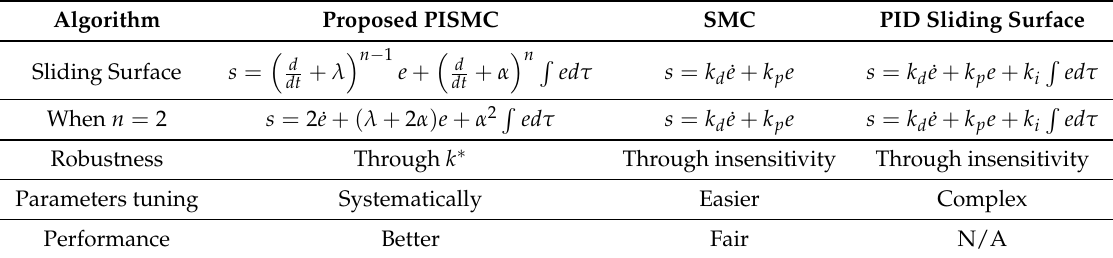
Table 2. Conceptual comparison between different control